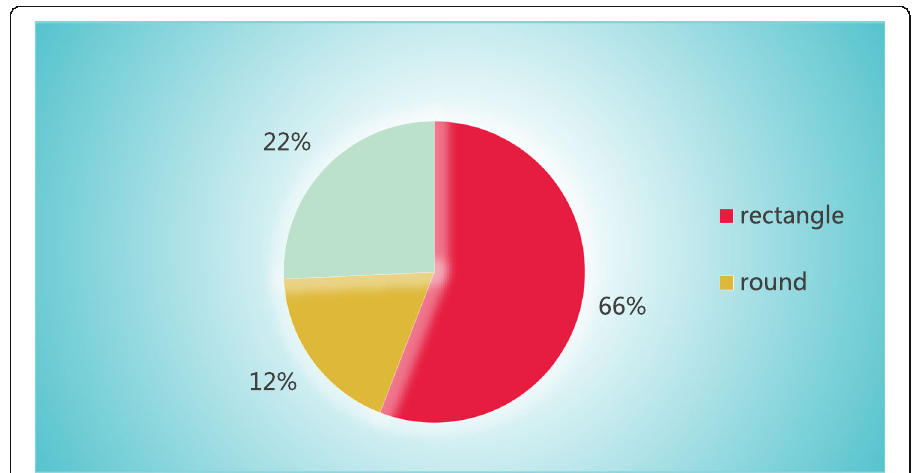
Fig. 3 Usage of trash cans with different shapes